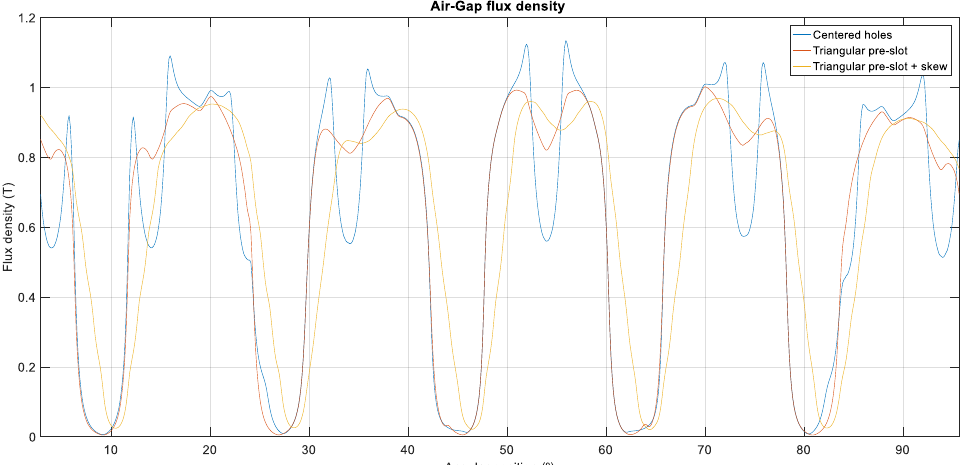
Figure 16. Air gap magnetic flux of the centered holes PMSG model, triangular pre-slot model, and triangular pre-slot model with skewing (with manufacturing errors).